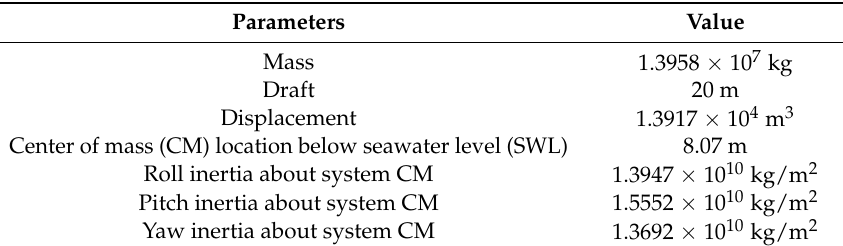
Table 1. Full system structural properties.